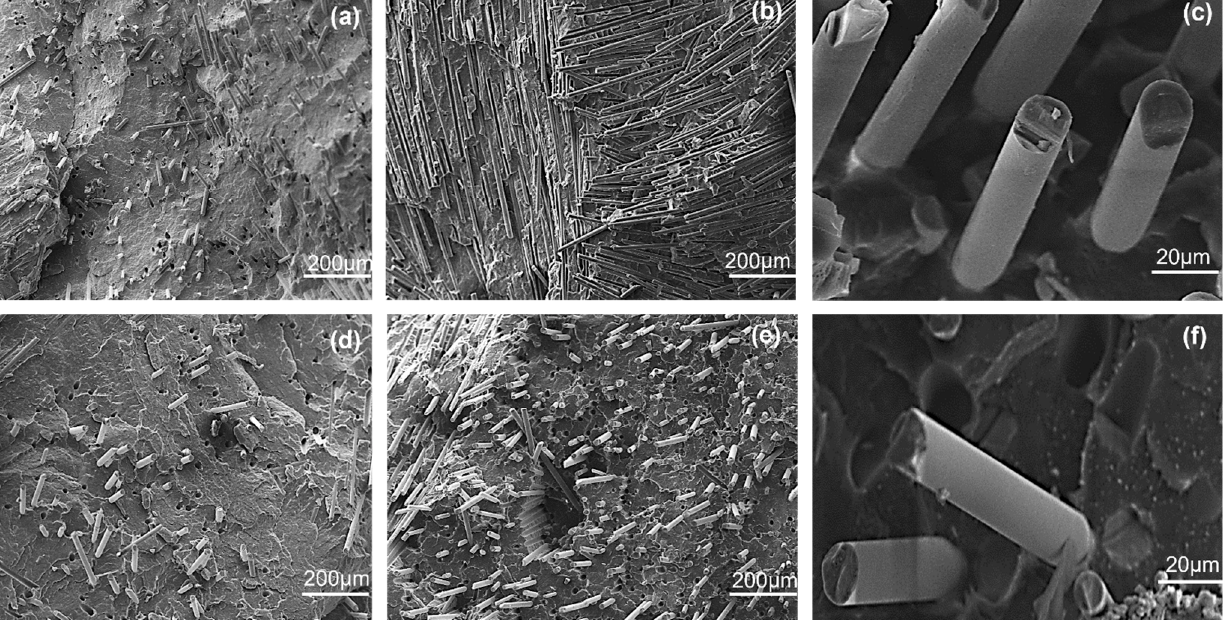
Figure 7. SEM micrographs of PA 66 compounds reinforced with 15 wt.% ( a ) and 25 wt.% ( b ) of GF; or 15 ( d ) and 25 wt.% ( e ) of BF at scale bar of 200 µm. SEM micrographs of PA66/GF ( c ) and PA66/BF or 15 ( d ) and 25 wt.% ( e ) of BF at scale bar of 200 µ m. SEM micrographs of PA66/GF ( c ) and PA66/BF ( f ) at scale bar of 20 µm. ( f ) at scale bar of 20 µ